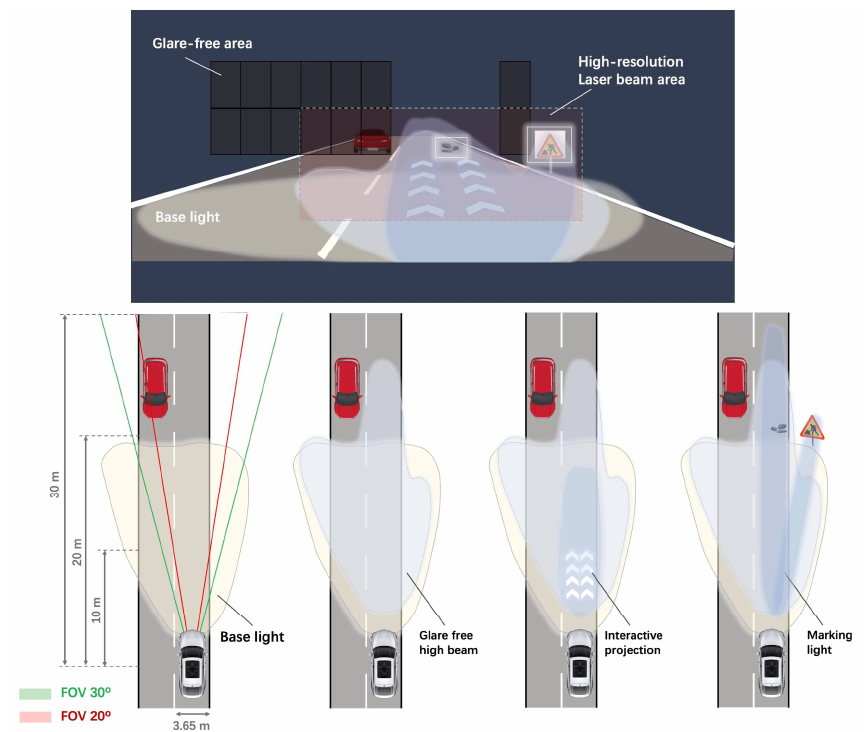
Figure 1. The schematic of the MEMS scanning adaptive laser headlights with different road illumi- nation functions. nation